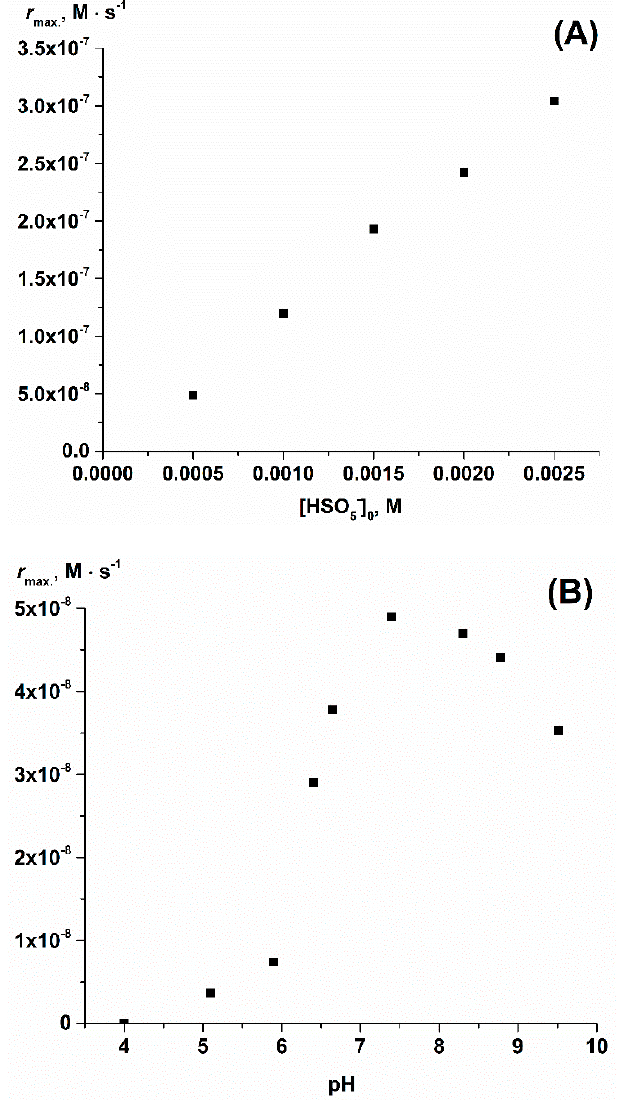
Figure 5. ( A ) The plot of the maximum rate of the reaction between Orange II (5.7·10 − 5 M) and HSO 5- in the presence of H 2 OCbl (1.0·10 − 6 M) versus the initial concentration of HSO 5- at pH 7.4, 25.0 °C. ( B ) The plot of the maximum rate of the reaction between Orange II (5.7·10 − 5 M) and HSO 5- (5.0·10 − 4 M) in the presence of H 2 OCbl (1.0·10 − 6 M) versus pH at 25.0 °C.